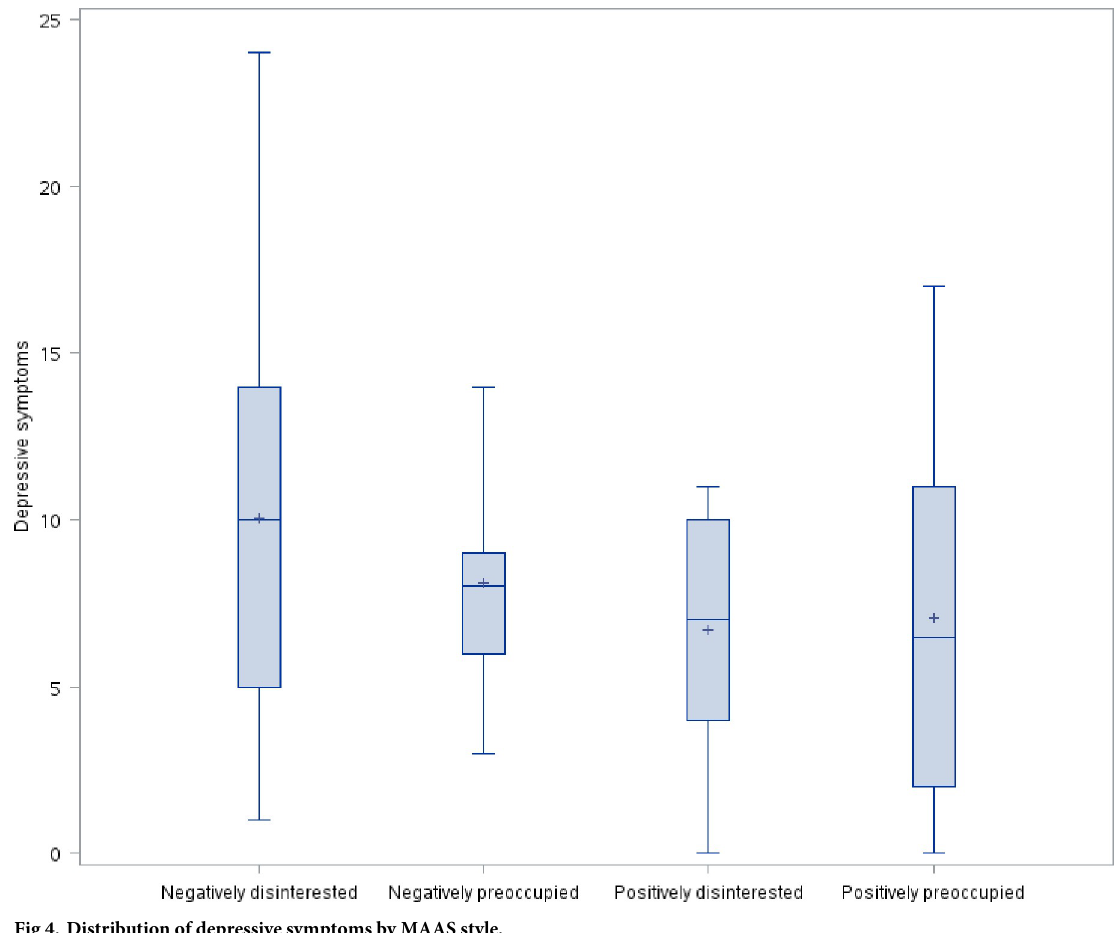
Fig 4. Distribution of depressive symptoms by MAAS